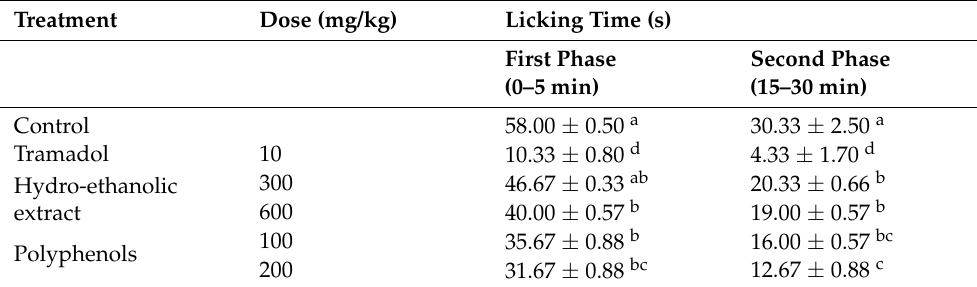
Table 4. Effect of the hydroethanolic and polyphenolic extracts of L. officinalis Chaix. on formalin- induced pain in